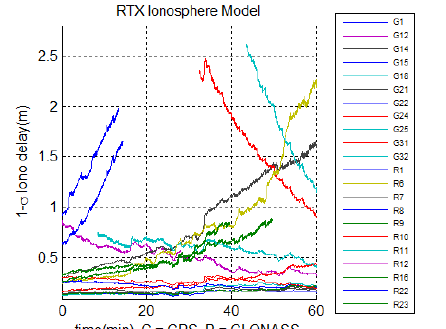
Figure 10: Ionospheric correction accuracy (1-σ ) for the dataset with the slowest position fixing (42.9 min)